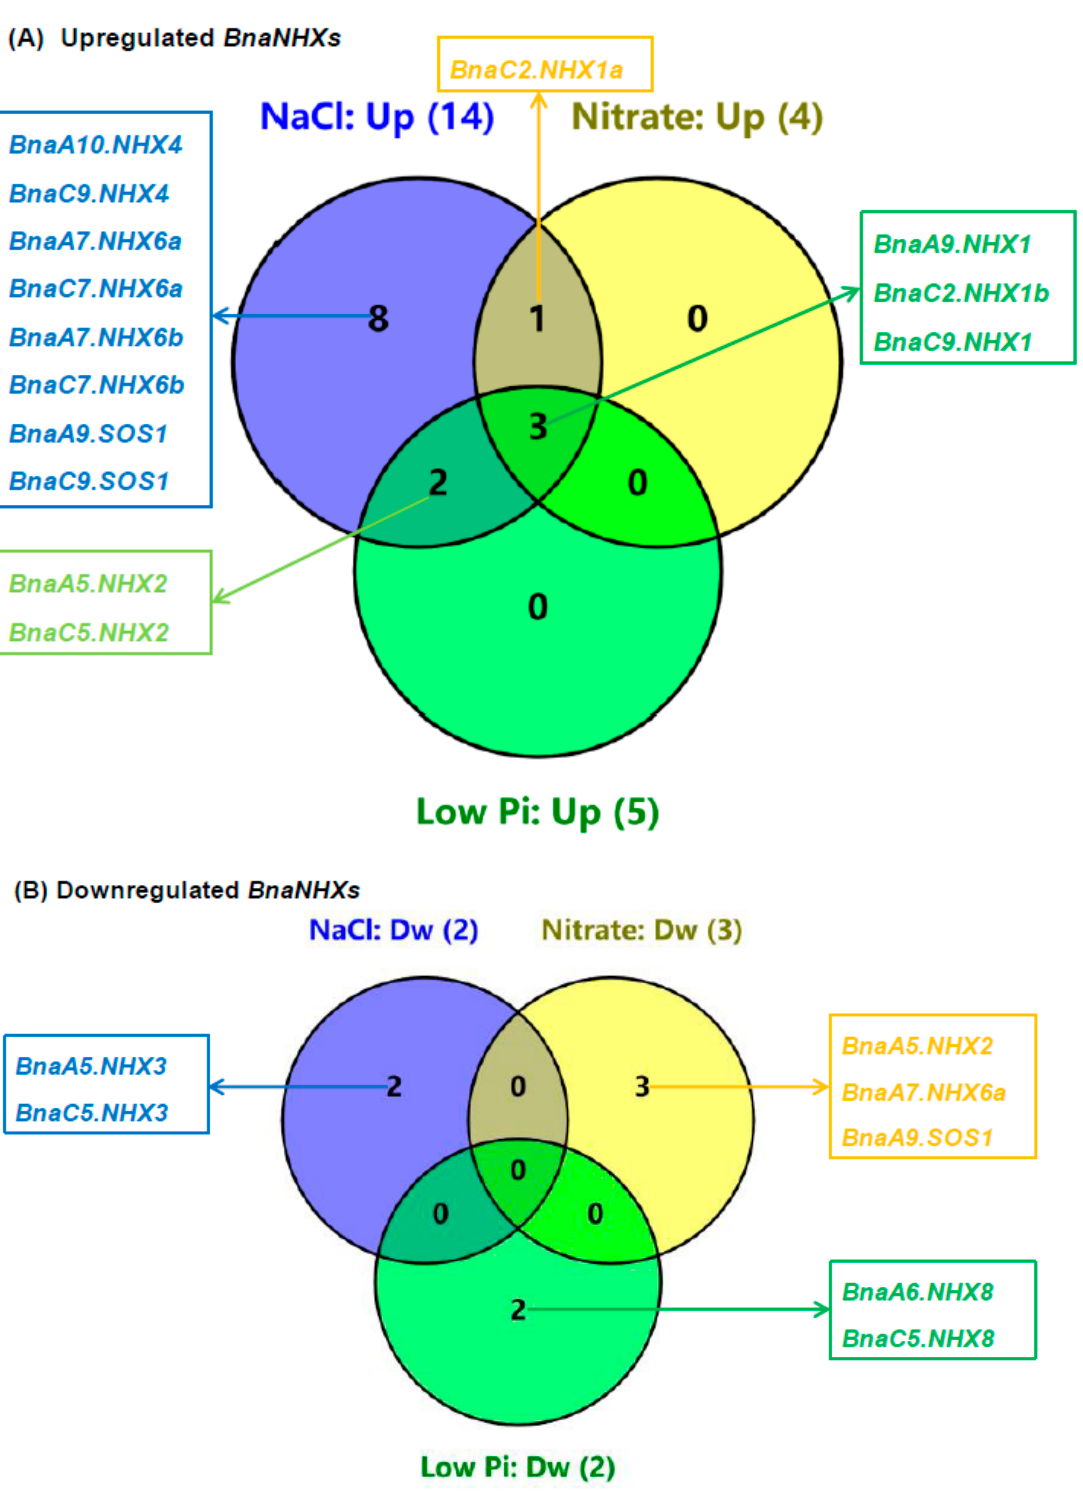
Figure10. Venndiagramssummarizingthetranscriptionalresponsesofthe Na +/ H + antiporters ( NHXs )in Figure 10. Venn diagrams summarizing the transcriptional responses of the Na+/H+ antiporters Brassica napus under diverse nutrient stresses. ( A , B ) Upregulated ( A ) and downregulated ( B ) BnaNHXs ( NHXs ) in Brassica napus under diverse nutrient stresses. ( A - B ) Upregulated ( A ) and downregulated in the rapeseed plants under di ff erent nutrient conditions. The di ff erentially expressed genes between ( B ) BnaNHXs in the rapeseed plants under different nutrient conditions. The differentially expressed di ff erent nutrient treatments were listed in the brackets. Up, upregulation; Dw, genes between different nutrient treatments were listed in the brackets. Up, upregulation; Dw, downregulation.